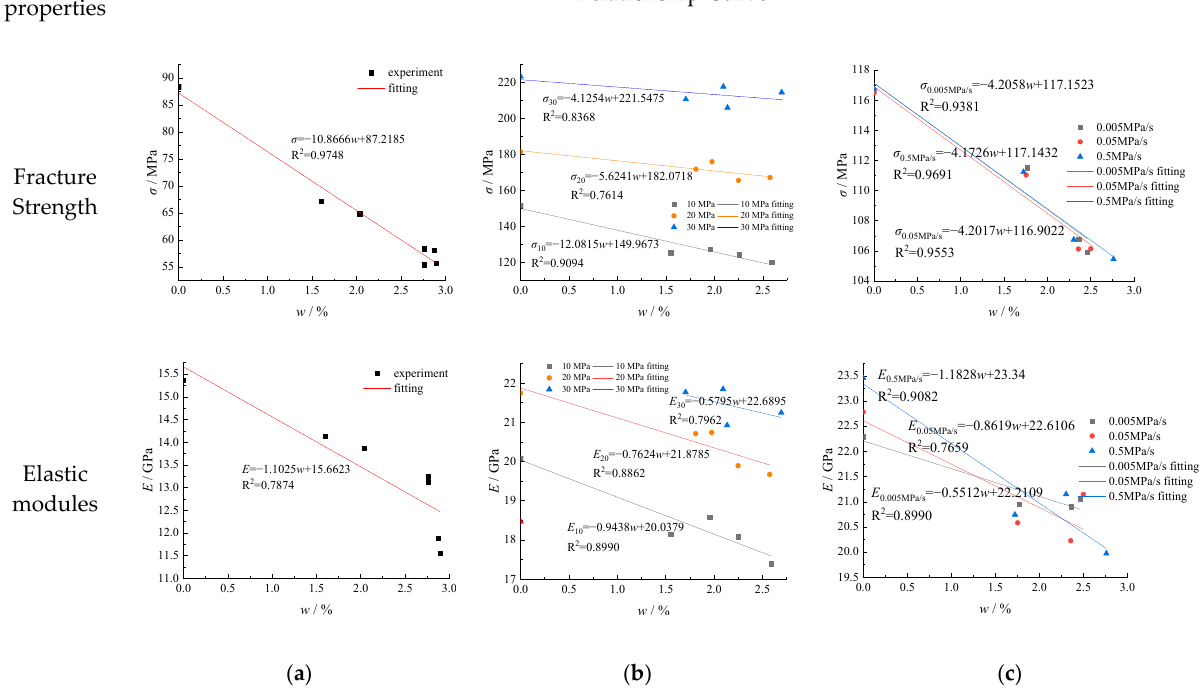
Figure 5. Relationship between mechanical parameters and water content. ( a ) Uniaxial compression test. ( b ) Triaxial compression test. ( c ) Const axial pressure and unloading confining